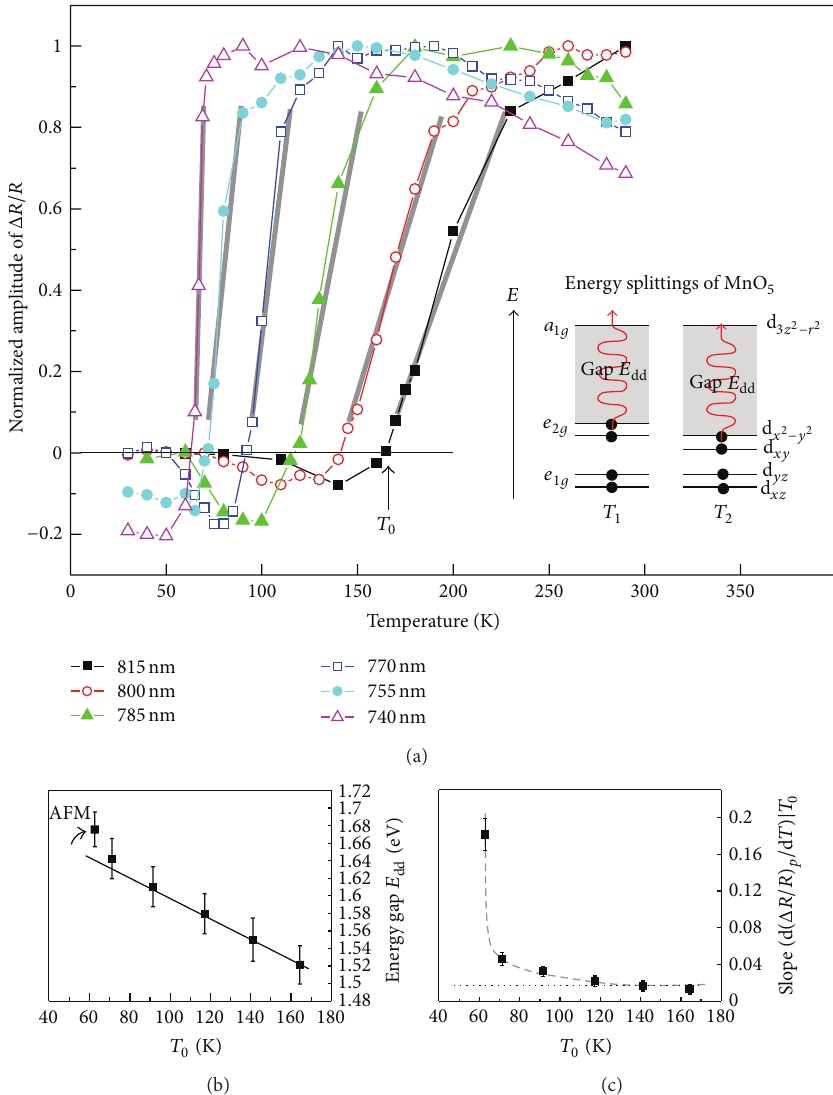
Figure 8: (a) Normalized amplitude of Δ𝑅/𝑅 as a function of temperature at various wavelengths. The insets illustrate splitting of the Mn 3+